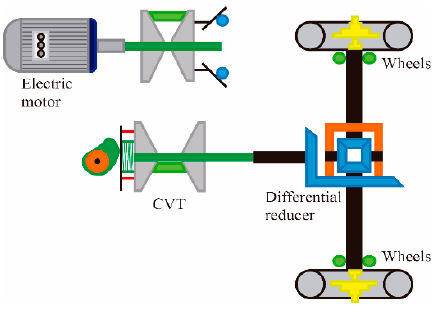
Figure 18. Electric powertrain.